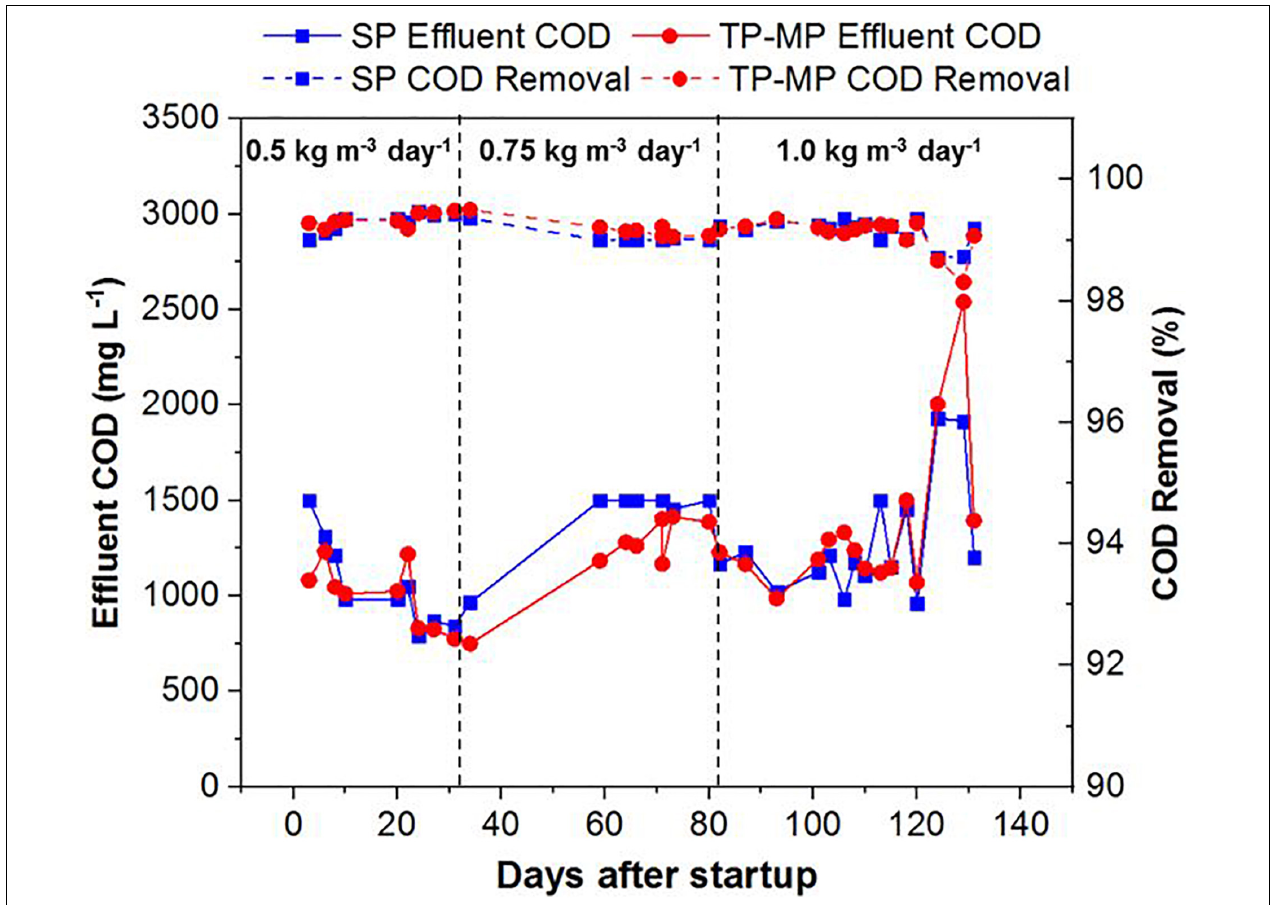
FIGURE 2 | Chemical oxygen demand of the effluent and removal efficiency at different fat loading rates in both single-phase and two-phase methane-phase AnMBRs (each data point is the average of duplicate measurements).